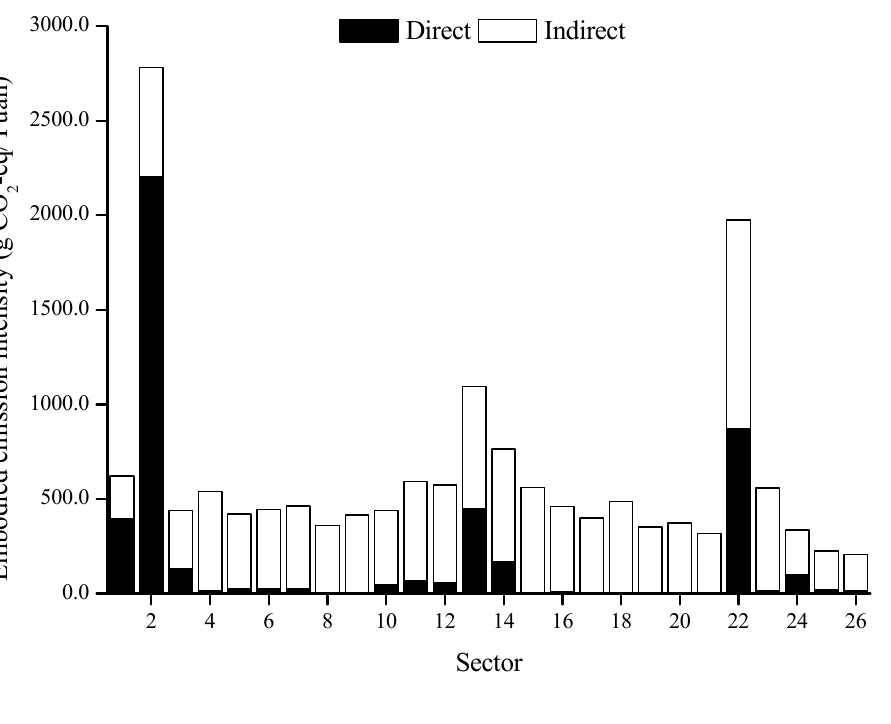
Figure 2. Embodied (direct plus indirect) GHG emission intensity by sector.